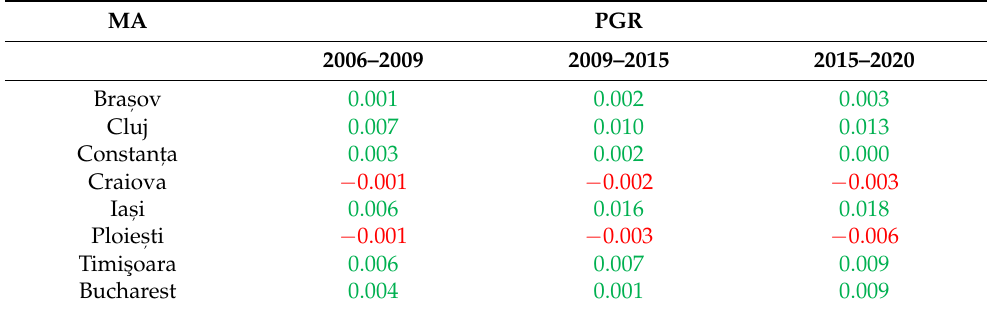
Table 5. Temporal variability of the PGR values at the level of metropolitan area (low 0–0.1, moderate,